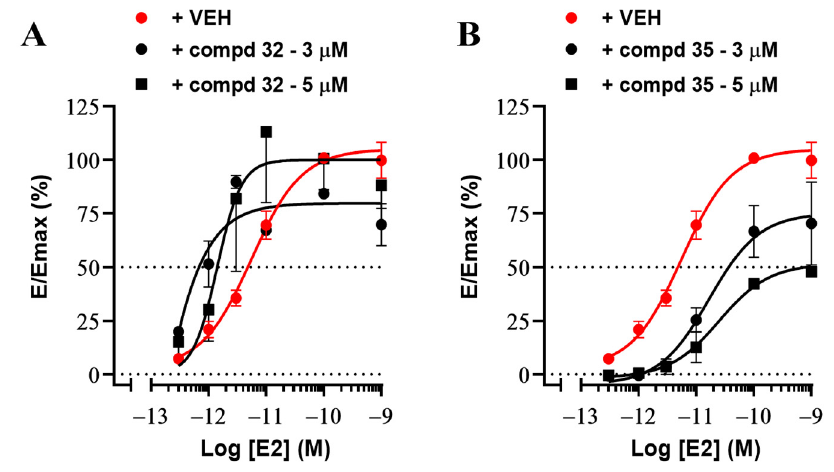
Figure 4. Differential inhibitory effects of 5-hydroxy-2 H -pyrrol-2-ones 32 and 35 on ER-dependent transcriptional activity. E2-depleted T47D-KBluc cells were pretreated with vehicle (VEH, 0.05% DMSO, ● ), compound 32 ( A ) or 35 ( B ) (both at 3 µM, ● or 5 µM, ■ ) for 3 h, followed by increasing E2 concentrations (0.3 pM–1 nM) for 16–24 h. Relative Luciferase activity (RLU) was measured as described in the Material and Methods. The maximal luciferase activity or Emax (15.19 ± 1.71-fold induction) was induced by E2, and the efficacy (E) of each treatment, as compared with Emax, was calculated (E/Emax %). Dotted lines are shown at 0 % and 50 % of E/Emax. Non-linear regression analysis was applied with GraphPad Prism software 8.4.3 to calculate the EC 50 values. Data are expressed as mean ± SEM for at least three independent experiments, where each treatment was tested in triplicate.